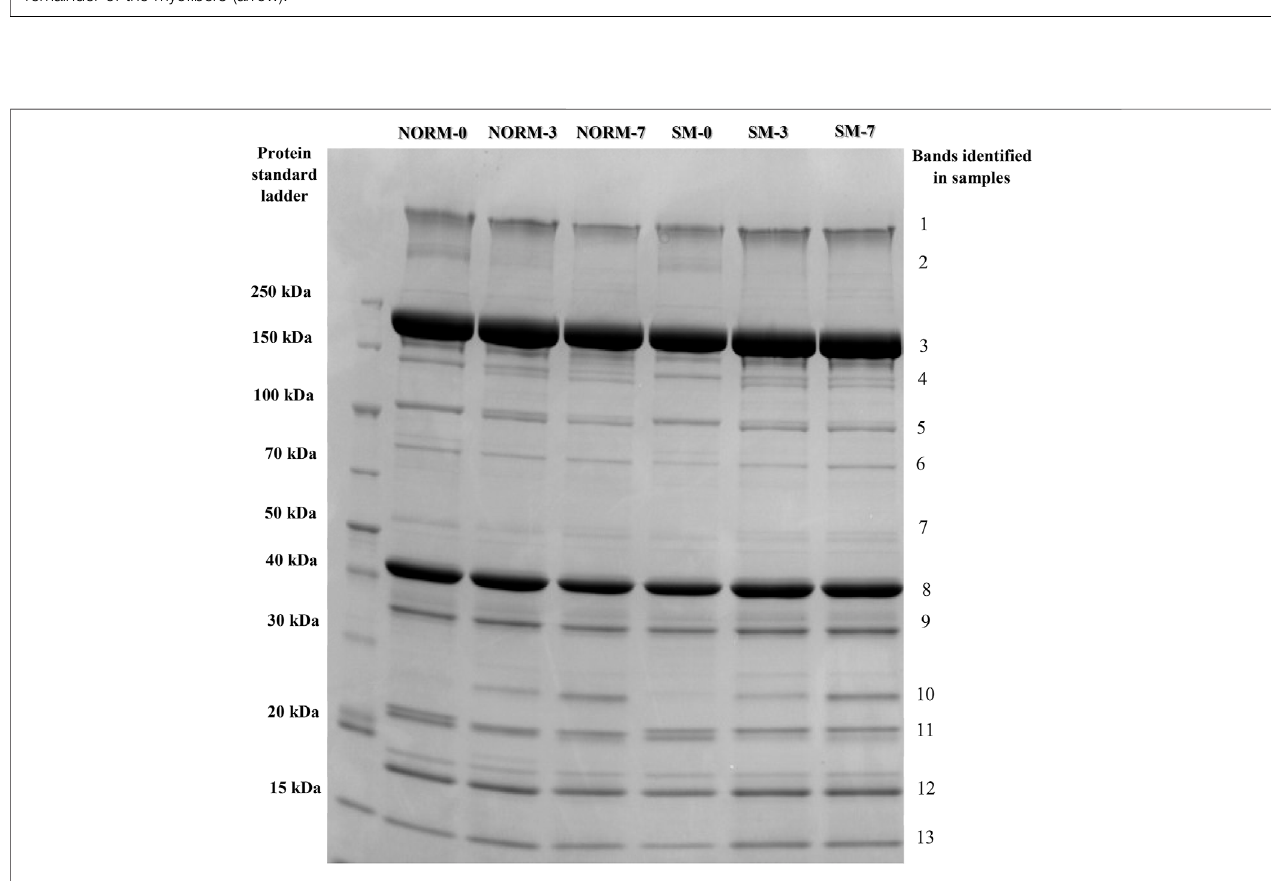
FIGURE 2 | Representative SDS-PAGE protein pro fi les of the myo fi brillar fraction according to muscle condition (M — normal, NORM; Spaghetti Meat, SM) and postmortem time (T — 0, 3, 7 days).